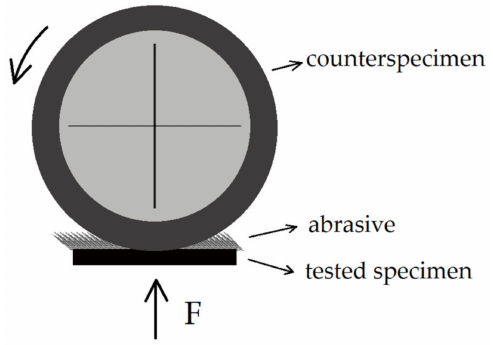
Figure 3. The scheme showing the principle of work of the T-07 tester. Images of the microstructures and surface topographies of the worn surfaces were recorded by means of a Phenom XL electron microscope (Phenom-World, Eindhoven, The Netherlands), which applied BSE imaging and an accelerating voltage of 15 keV.